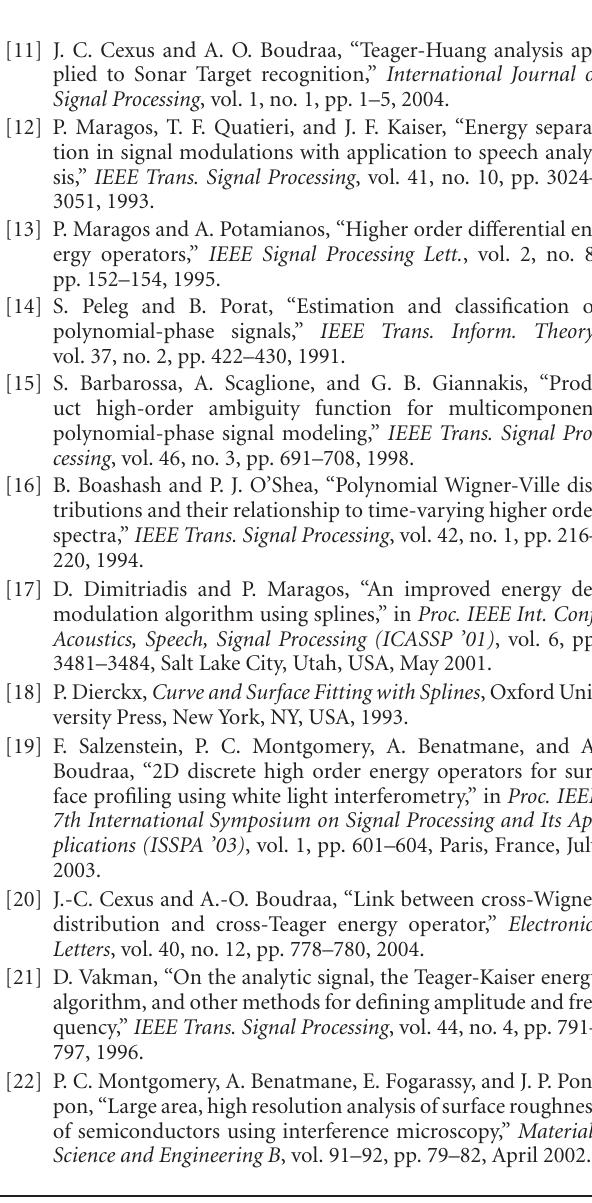
Figure 14: Surface profiles using undersampled data. (a) ( k , m ) = (0,3), T e = 240 nm and (b) ( k , m ) = (0,1), T e = 400 nm.